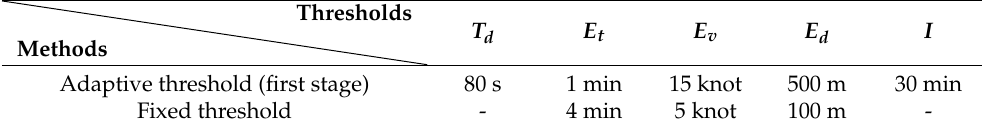
Table 3. Thresholds used in the experiments.